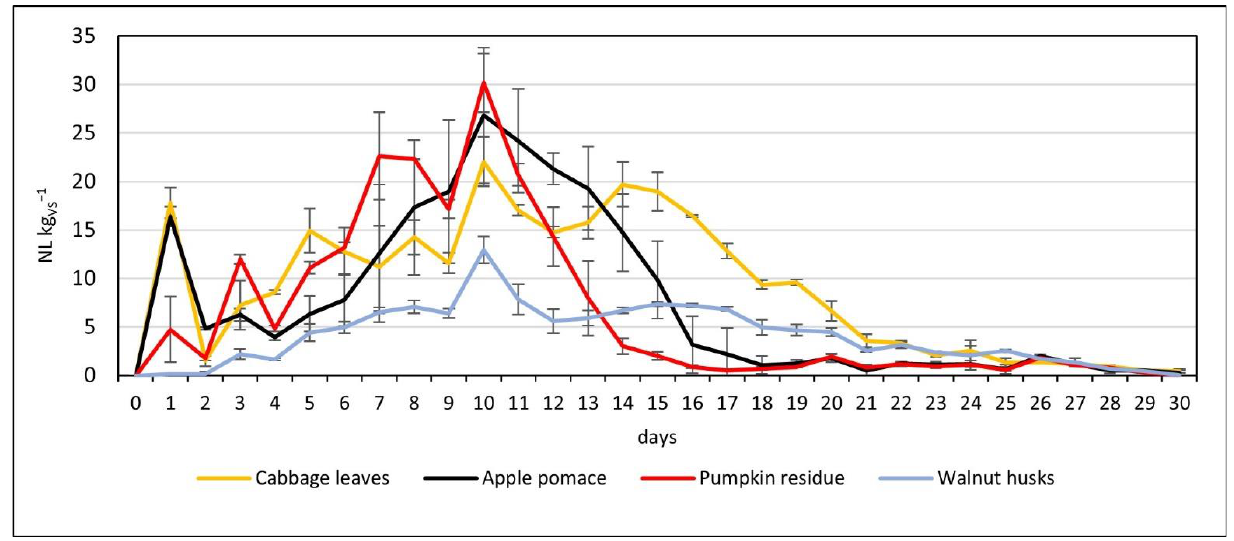
Figure 2. Daily methane production of four fruit and vegetable residues. Standard errors are shown as vertical bars.